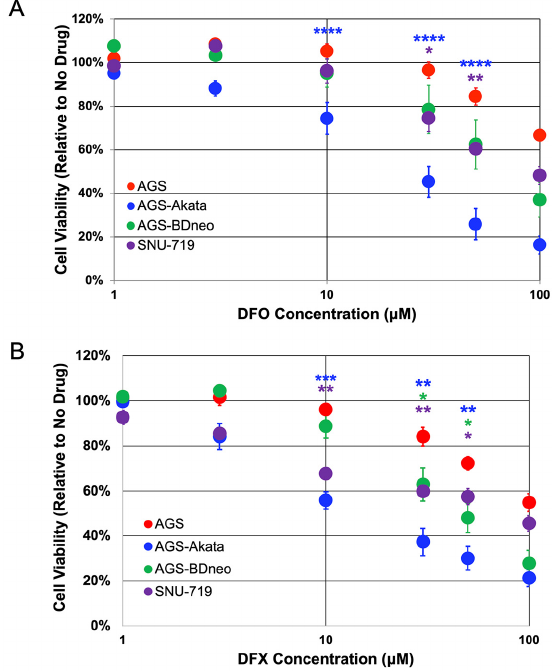
Figure 4. Cell viability of EBV-positive gastric cancer cell lines treated with DFO and DFX. EBV- positive cell lines AGS-Akata (blue), AGS-BDneo (green), and SNU-719 (purple) and EBV-negative AGS cells (red) were treated with the indicated concentrations of DFO ( A ) or DFX ( B ) for 24 h and then without drug for an additional 72 h . n = 4–9; *, p ≤ 0.05; **, p ≤ 0.005; ***, p ≤ 5 × 10 − 4 ; ****, p ≤ 5 × 10 − 5 for EBV + cells compared to EBV - AGS cells. comparing cell viability of EBV-positive to EBV-negative cells were calculated with a Stu- dent’s T -test.